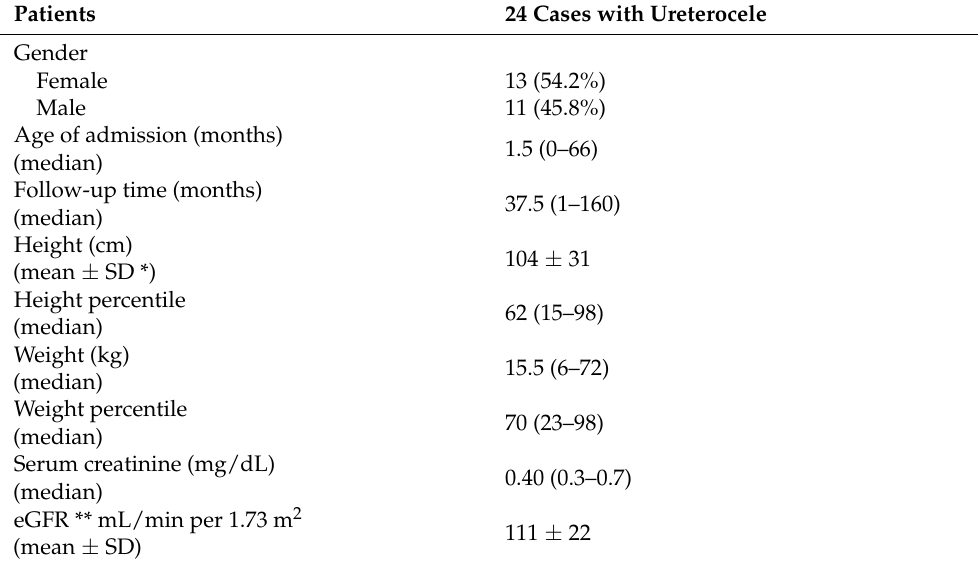
Table 1. Demographic and clinical data of patients with ureterocele.